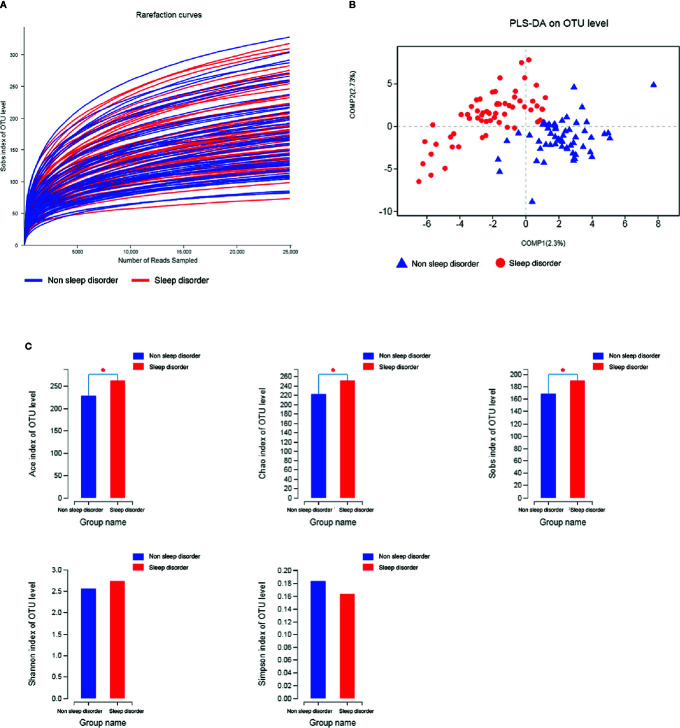
Rarefaction curves, PLS-DA, and α-diversity analysis of fecal samples from ASD children with and without sleep disorder. (A) Rarefaction curves calculated for OTUs with 97% identity for gut microbiota in sleep disorder and no sleep disorder groups. Blue curves represent the no sleep disorder group, and red curves represent the sleep disorder group. (B) PLS-DA plot based on unweighted UniFrac distance metrics. Blue triangles represent the no sleep disorder group, and red circles represent the sleep disorder group. (C) Comparison of ACE, Chao, Sobs, Shannon, and Simpson indices among the two groups. The blue column represents the no sleep disorder group, the red column represents the sleep disorder group, and α-diversity indices analyzed by Student’s t-test are reported as mean ± SD (*p < 0.05).